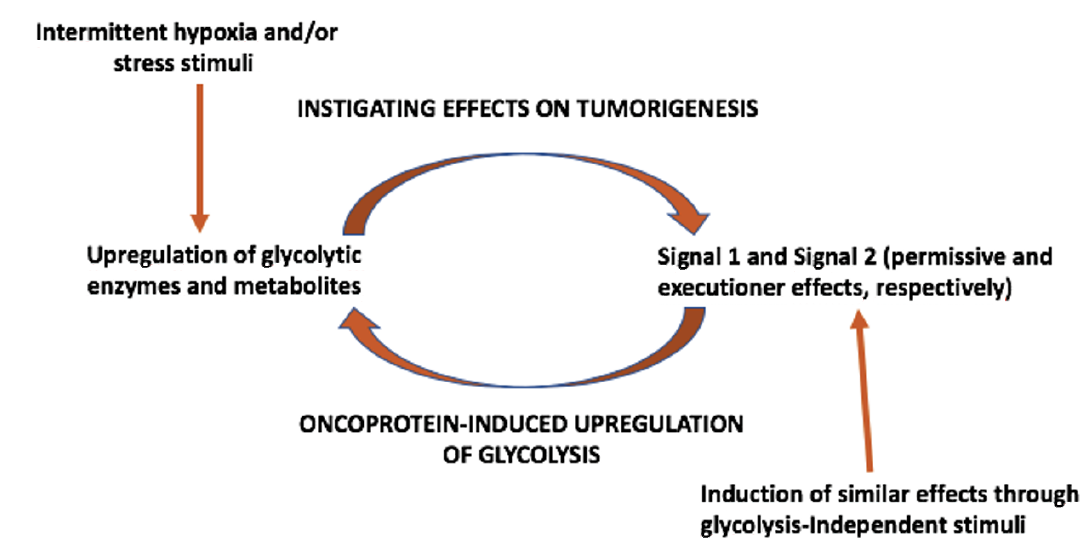
Figure 4. Feed-Forward Amplification Loop between Upregulated Glycolysis and Oncoproteins in Promoting Early Tumorigenesis. Intermittent hypoxia and/or other stress stimuli can induce the upregulation of glycolysis and such upregulation may induce Signal 1 and/or Signal 2 (permissive and executioner effects, respectively) as illustrated in Figure 3. Oncoproteins may, by themselves, upregulate glycolysis, thereby making glycolytic enzymes and metabolites available for the renewed induction of oncogenic signaling mechanisms. This feed-forward regulation may be at the basis of the multistep process that is known to be required to achieve full-blown tumor growth. We suggest that permissive and executioner effects can be induced by other glycolysis-independent